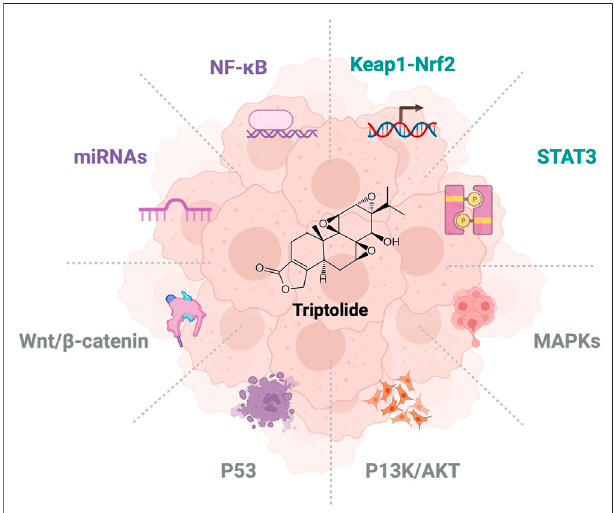
FIGURE 1 | Overview of triptolide on signaling pathways for NSCLC